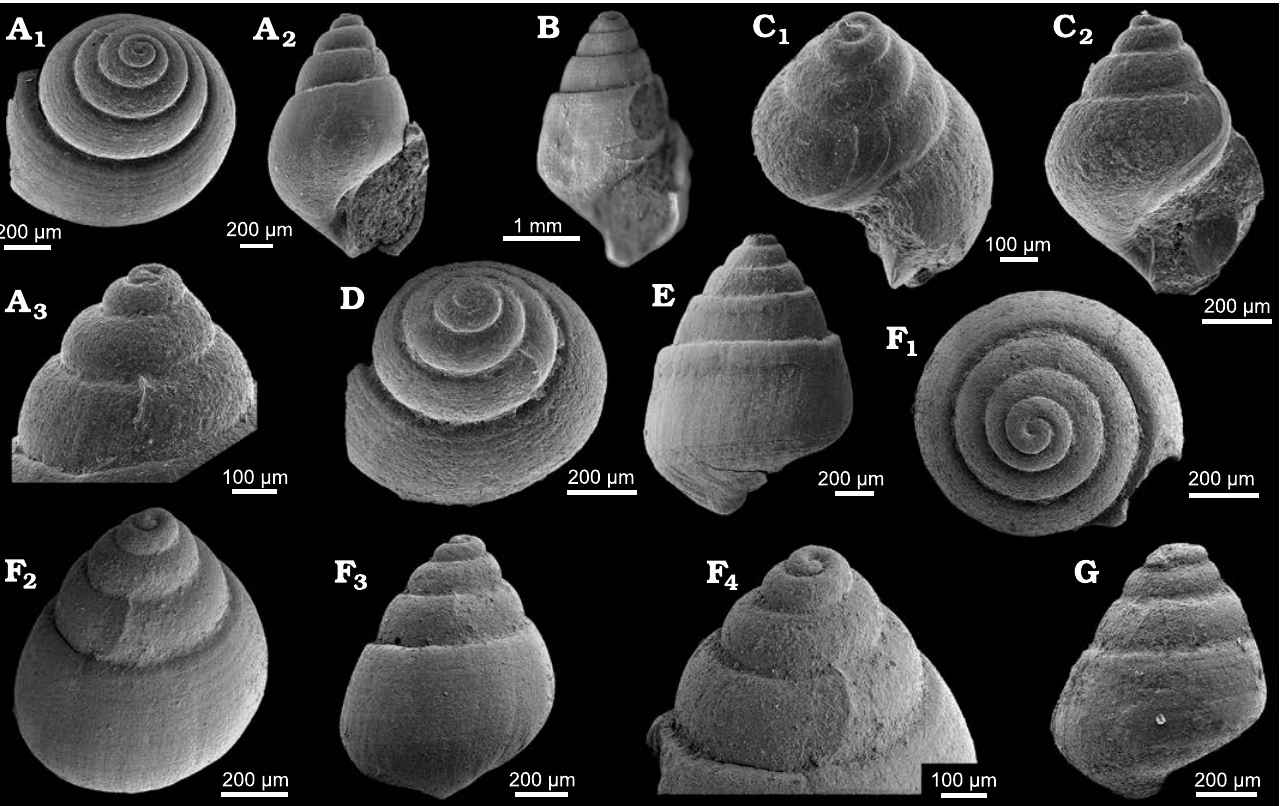
Fig. 11. Coelostylinid gastropods Coelostylina conica (Münster, 1841) from Lago Antorno (A–D) and Misurina Landslide (E–G), northern Italy, Cassian Formation, Carnian, Upper Triassic. A . PZO 12807, A 1 , teleoconch shows faint spiral furrows in oblique apical view; A 2 , apertural view; A 3 , protoconch in lateral view with sinusigera. B . PZO 12808, in apertural view, with drill hole. C . PZO 12809, C 1 , juvenile whorls including protoconch ending at si- nusigera, in oblique lateral view; C 2 , juvenile whorls including protoconch ending at sinusigera, in apertural view. D . PZO 12810, teleoconch shows faint spiral furrows, end of smooth larval shell well visible, in oblique apical view. E . PZO 12688, in lateral view. F . PZO 12689, F 1 , juvenile whorls including protoconch in apical view; F 2 , juvenile whorls including protoconch, in lateral view; F 3 , juvenile whorls including protoconch, in lateral view; F 4 , juvenile whorls including protoconch with dipping initial whorl, in lateral view. G . PZO 12690, juvenile whorls including protoconch, in lateral